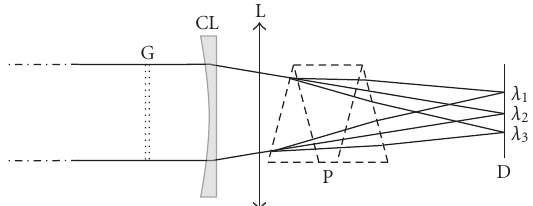
Figure 2: Side view of the spectroscopic output imaging system: G: di ff raction grating; CL: cylindrical lens; L: spherical lens; P: prism; D: